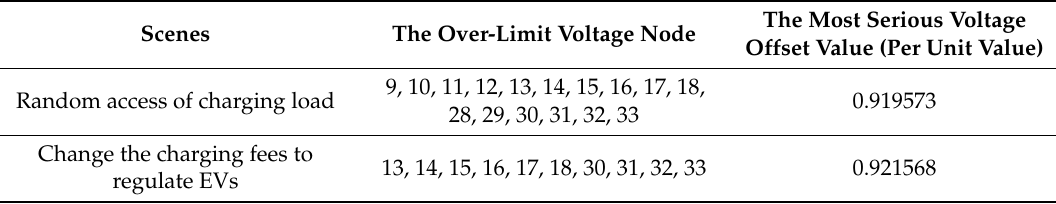
Table 2. Voltage off-limit situation in IEEE-33 system.